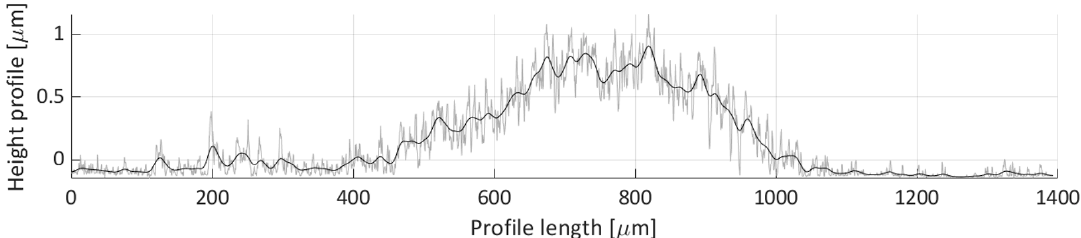
Figure 26. Height profile for the H6 line.